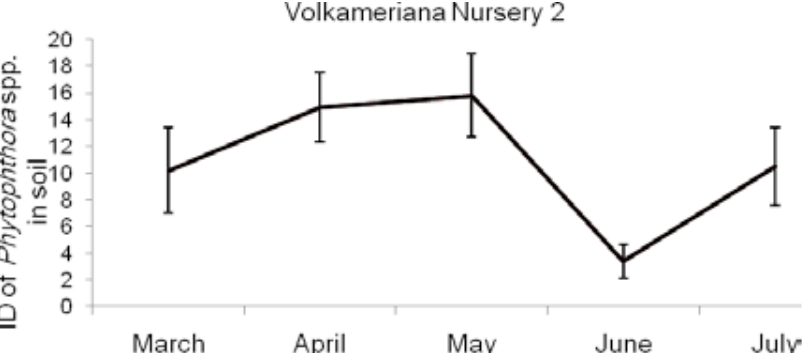
Figure 3. Seasonal variation of Phytophthora spp. inoculum density (ID) in Nursery 2, expressed as propagules/gram of dry